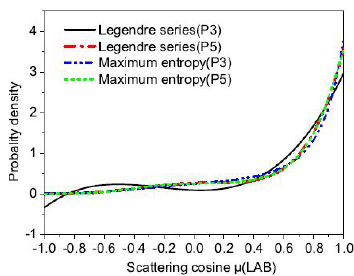
Figure 5. Exponential representation compared to the Legendre series truncated at order 3 and 5 for neutron scattering from group 89 to group